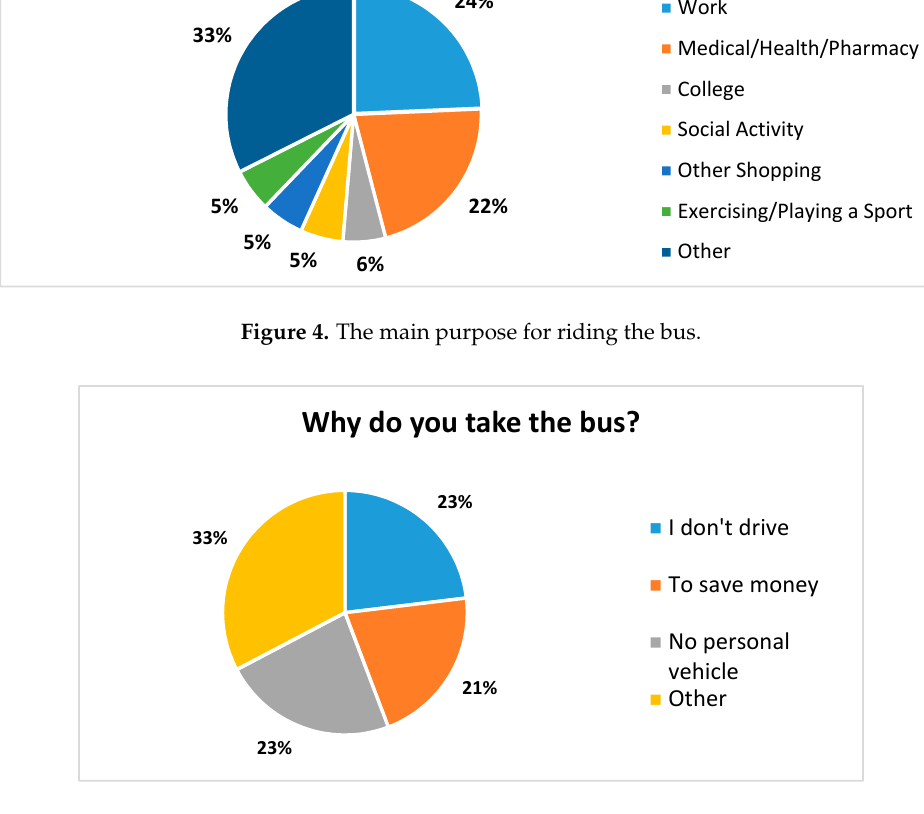
Figure 6. Perceptions about the bus service. Figure 7. How do you get to your bus stop?